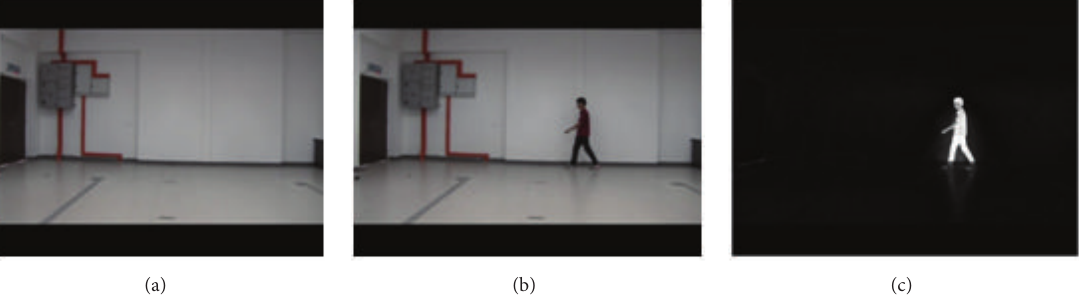
Figure 3: Process of object extraction. (a) Empty background frame. (b) New frame with walking subject. (c) Difference